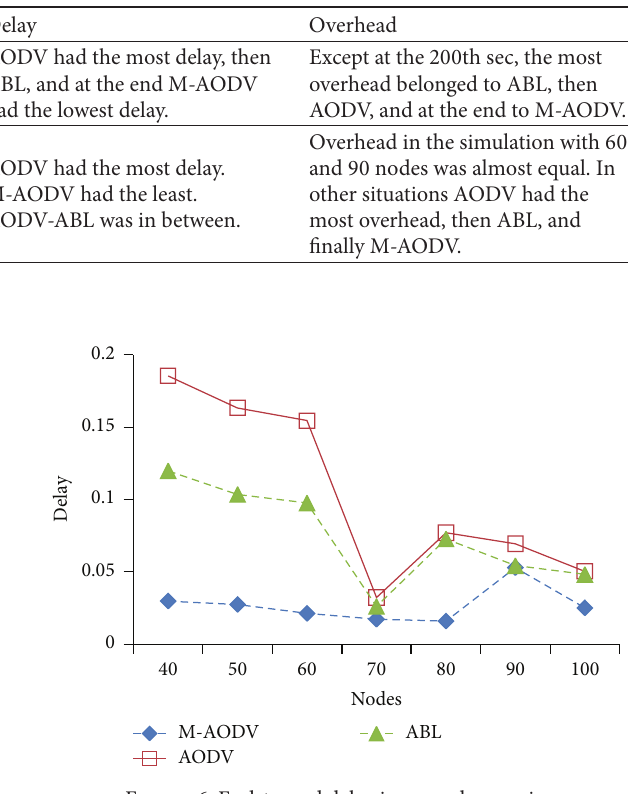
Table 3: Evaluation of simulation results.